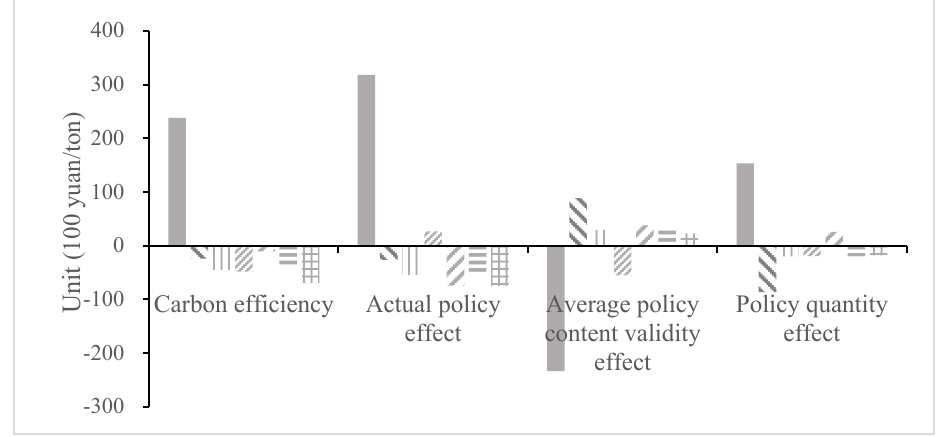
Figure 7. LMDI decomposition of carbon emissions reduction effects of CET policies in pilot regions across space (2017). (Note: the relevant mean values of the pilot regions were used as a comparative benchmark for LMDI decomposition in the spatial analyses; the data supporting the figure were calculated by the authors).